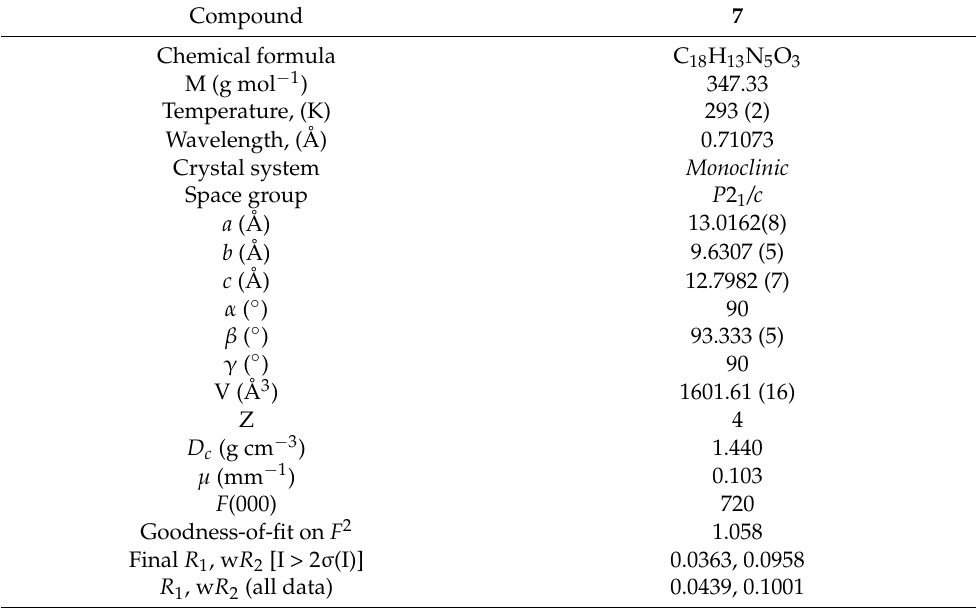
Table 1. Crystallographic data, details of data collection, and structure refinement parameters for compound 7